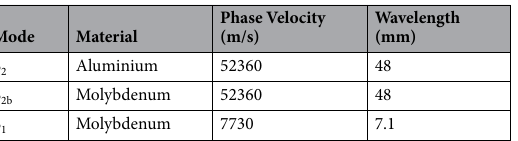
Table 2. Parameters of the modes of interest used for the calculation of wavelength for different Lamb modes in the Material Contrast